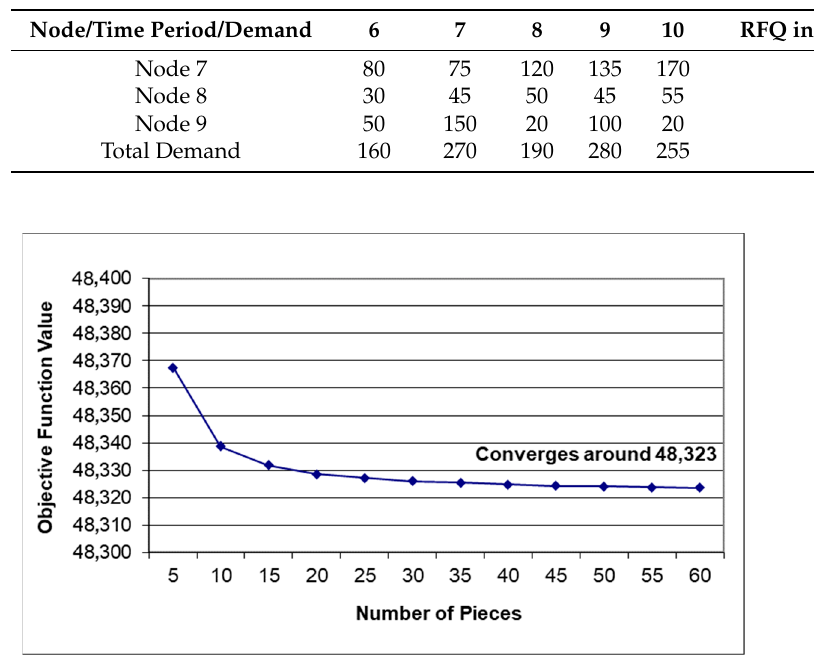
Figure 5. Inner approximation.